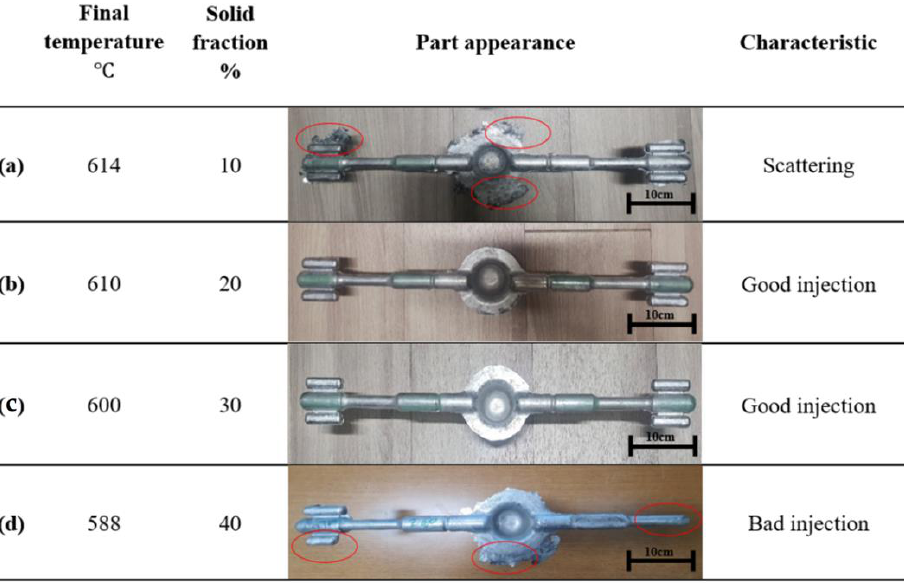
Figure 5. Castability according to solid fraction: ( a ) T = 614 ◦ C, fs = 10%, ( b ) T = 610 ◦ C, fs = 20%, ( c ) T = 600 ◦ C, fs = 30%, ( d ) T = 600 ◦ C, fs = 40%.